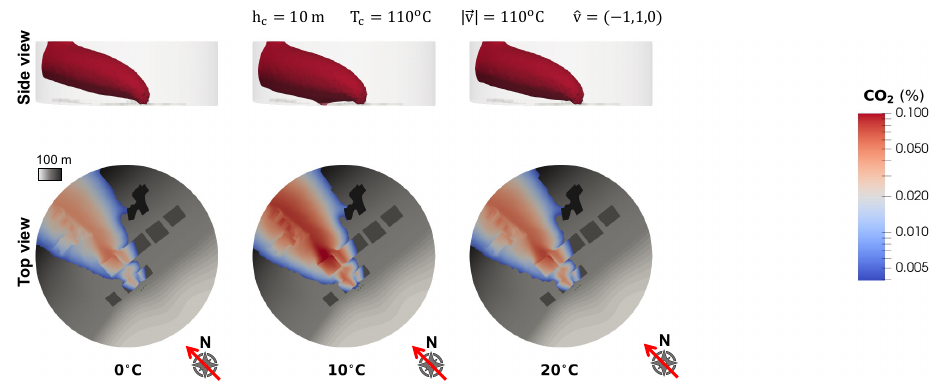
Figure 8. Ambient Temperature. Concentration of CO 2 at ground level for wind speed u = 5 m/s and north-west ( − 1,1,0 ) direction. The chimney height is 10 m and the exhaust gas temperature 110 ◦ C in all cases. The terrain height is represented in a grayscale. Lighter colors correspond to lower heights and the sea has the lightest color. The chimneys are three white spots near the coastline. The upper panels, show the concentration of CO 2 within the plume. The 0.1%, 1000 ppm, surface for CO 2 was plotted in all cases.